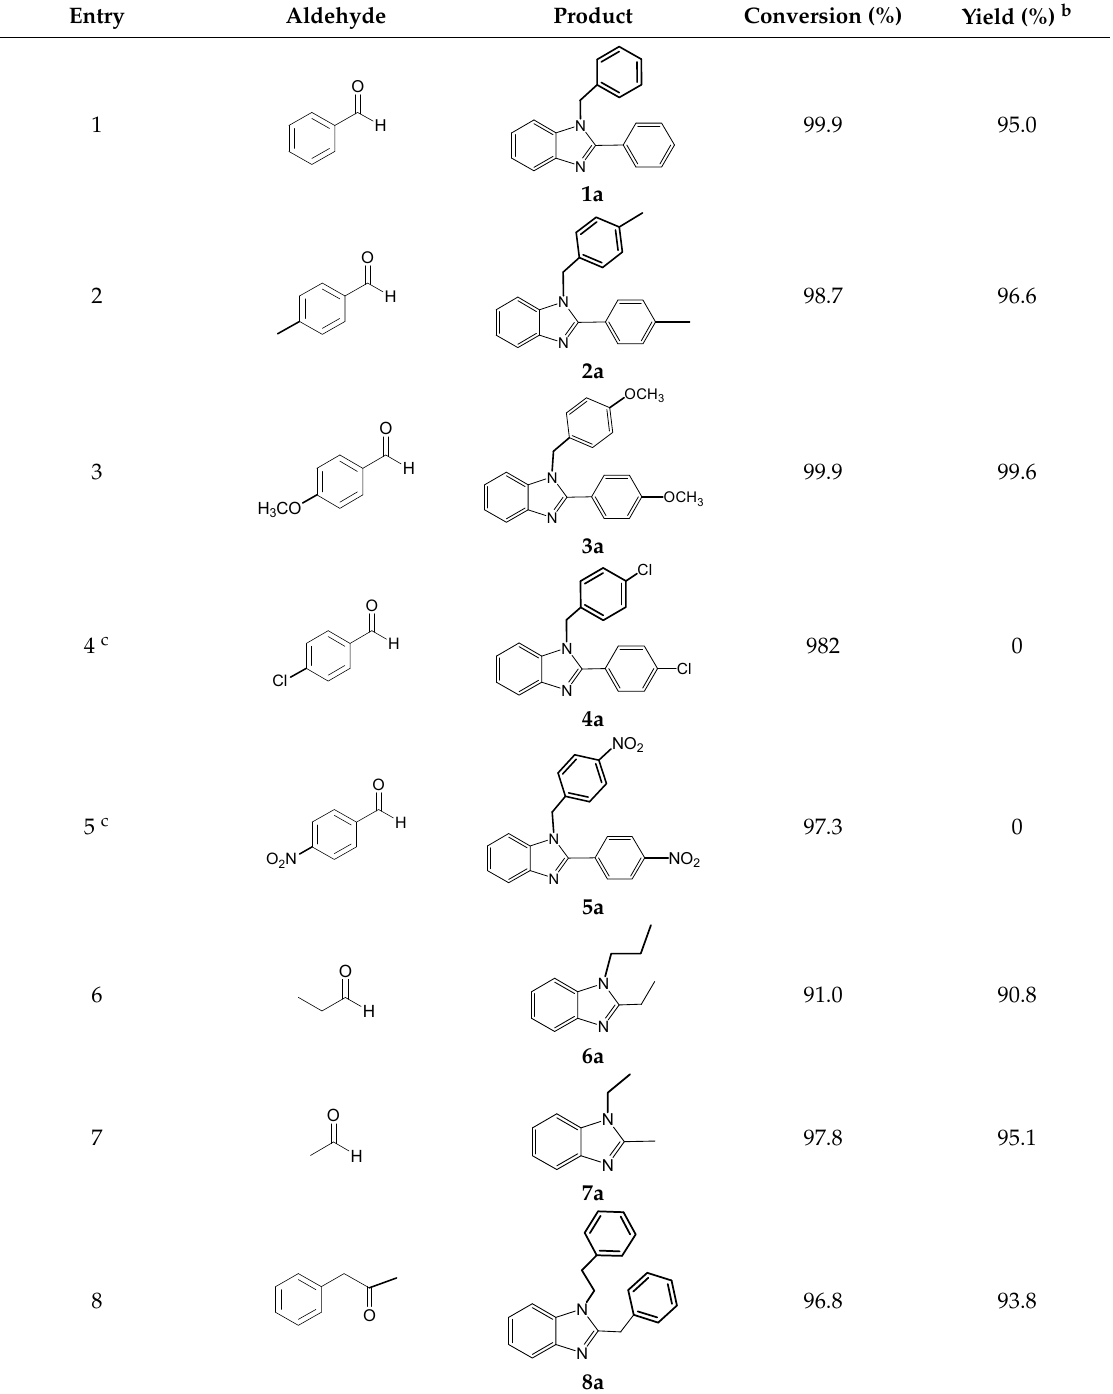
Table 2. Synthesis of 1,2-disubstituted benzimidazoles. a